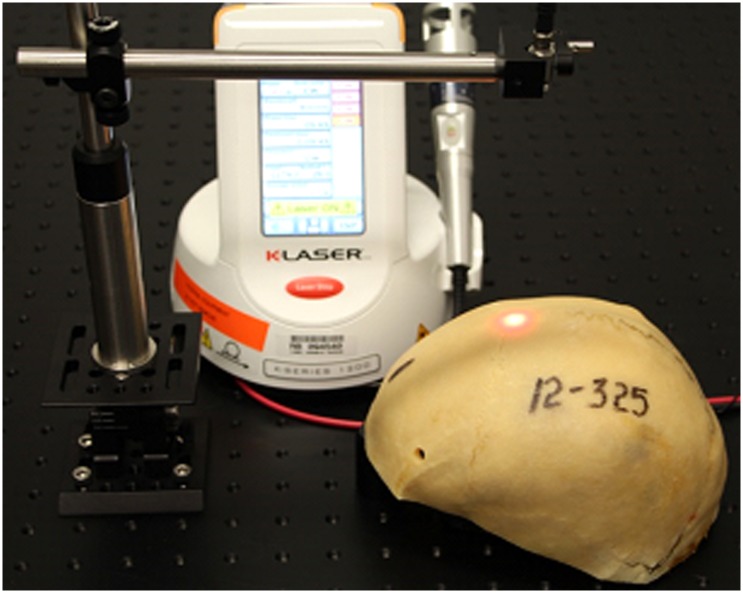
NILT Penetration Physical Set-up.Penetration Assembly and NILT Treatment at Bregma for example human calvaria #12–325.